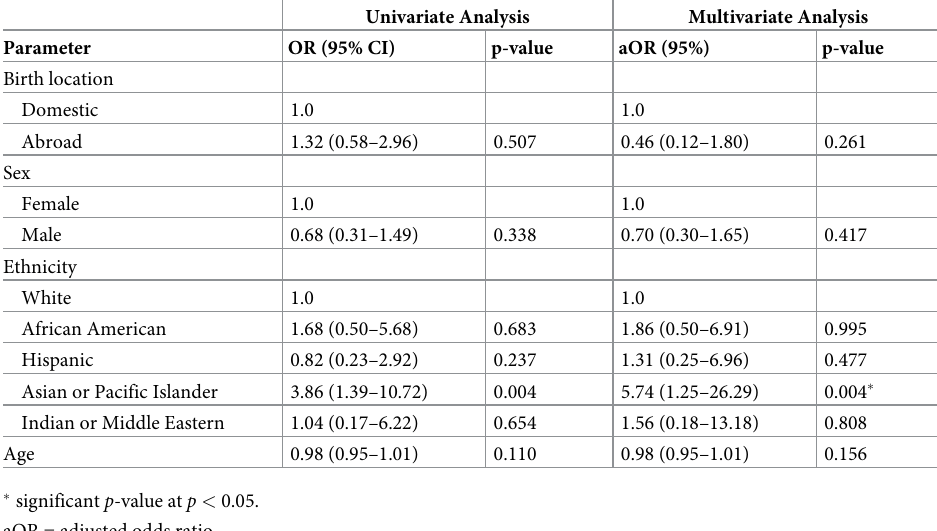
Table 2. Logistic regression model for the years